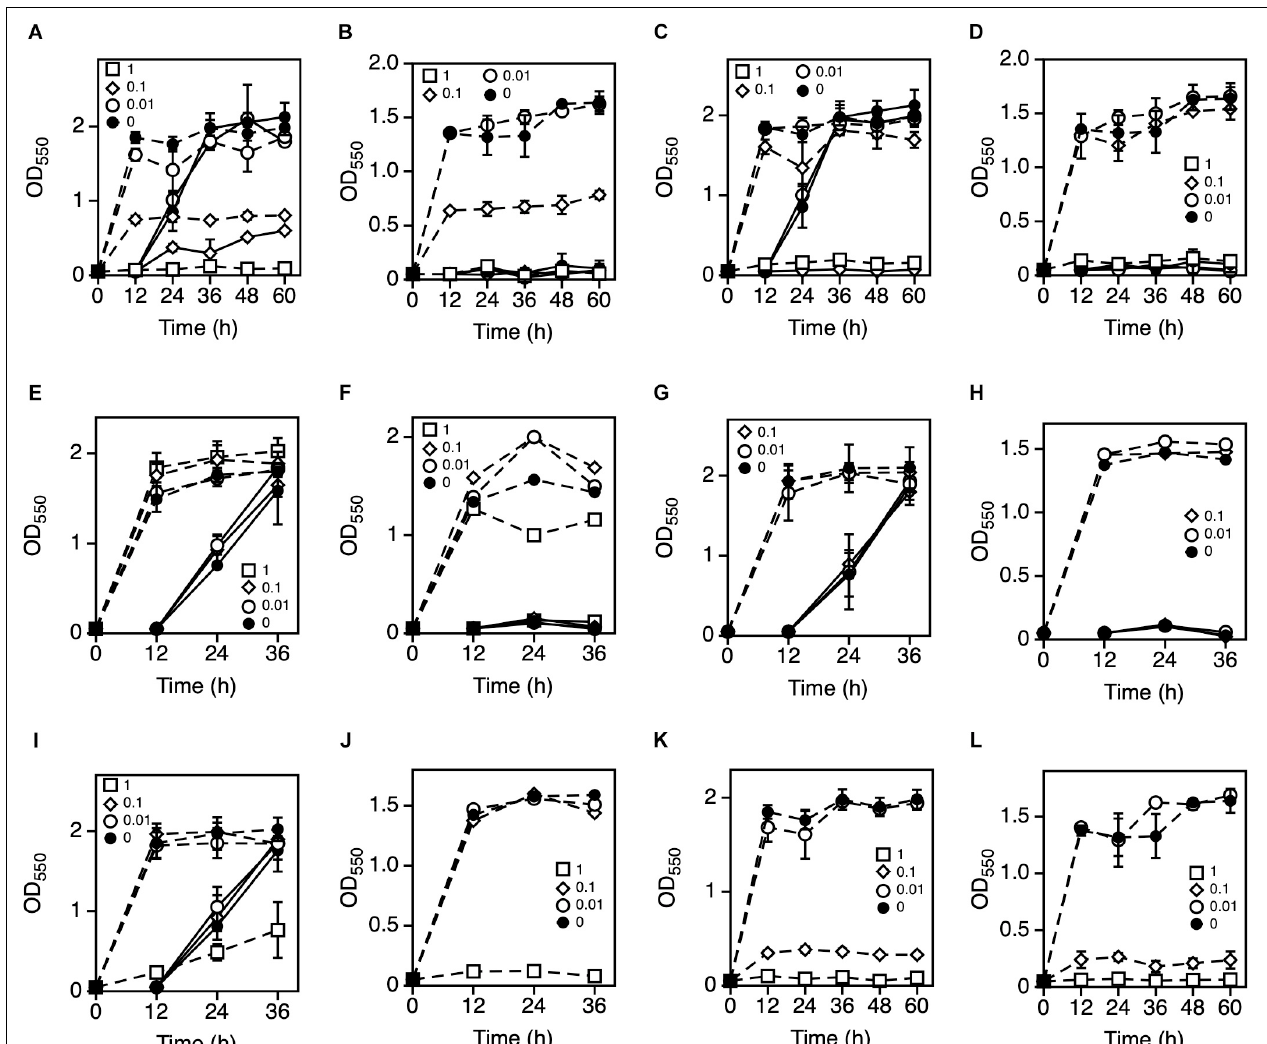
FIGURE 1 | Effects of various metal ions on the two-step cultivation of Zymomonas mobilis TISTR 548. Cells were cultivated in YPD medium at 38 ◦ C with different concentrations of NiCl 2 (A) , ZnCl 2 (C) , FeCl 3 (E) , AlCl 3 (G) , MnCl 2 (I) , or CoCl 2 (K) and at 39 ◦ C with NiCl 2 (B) , ZnCl 2 (D) , FeCl 3 (F) , AlCl 3 (H) , MnCl 2 (J) , or CoCl 2 (L) under a static condition. These symbols indicate the means of three replicates, and error bars indicate standard deviations: closed circle, control (0 mM); open circle, 0.01 mM; open diamond, 0.1 mM; and open square, 1.0 mM. Dotted and solid lines indicate the OD values of the first and second stages of cultivation,